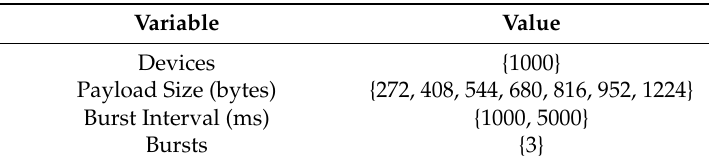
Table 4. Experiment 2